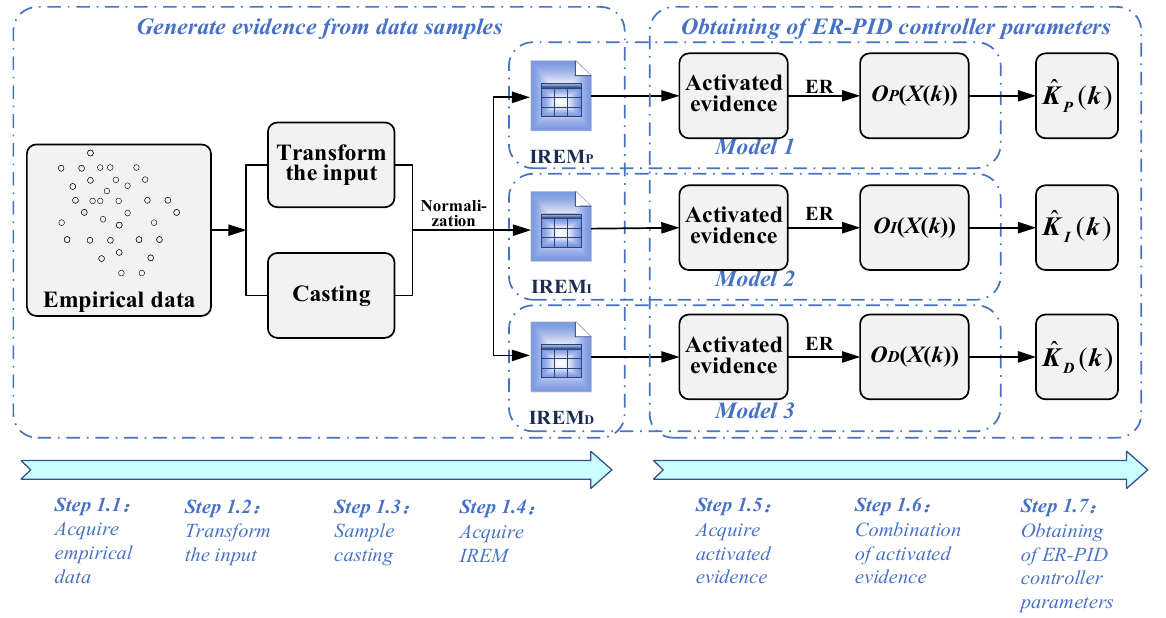
Figure 5. Process of obtaining the ER ‐ PID parameters.